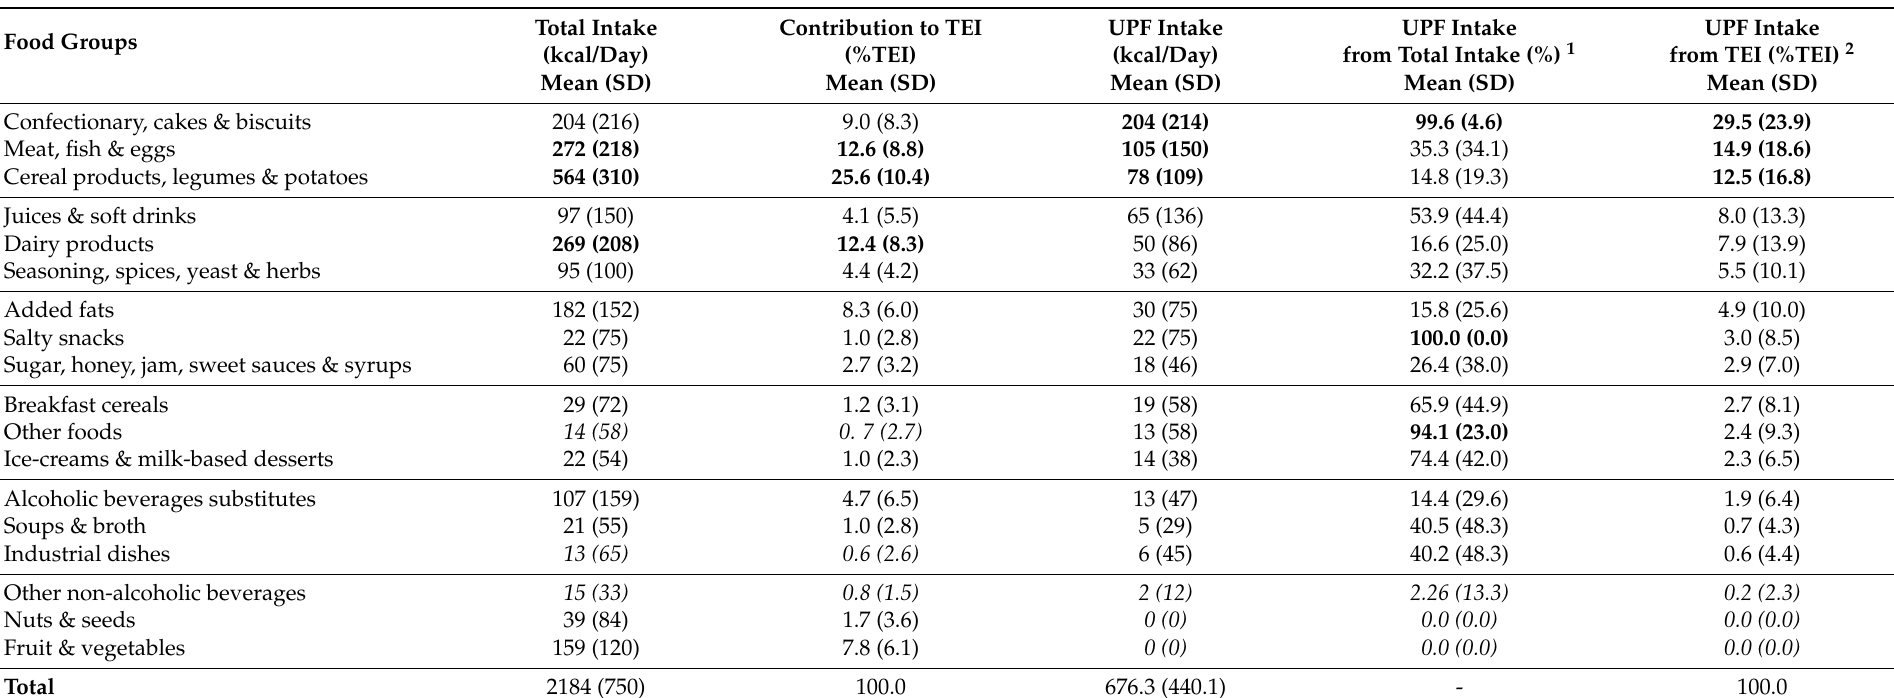
Table 2. Distribution of energy intake (kcal) from UPFs by food group, in decreasing order (N = 2085, bold = 3 largest numbers, italic = 3 smallest numbers, by